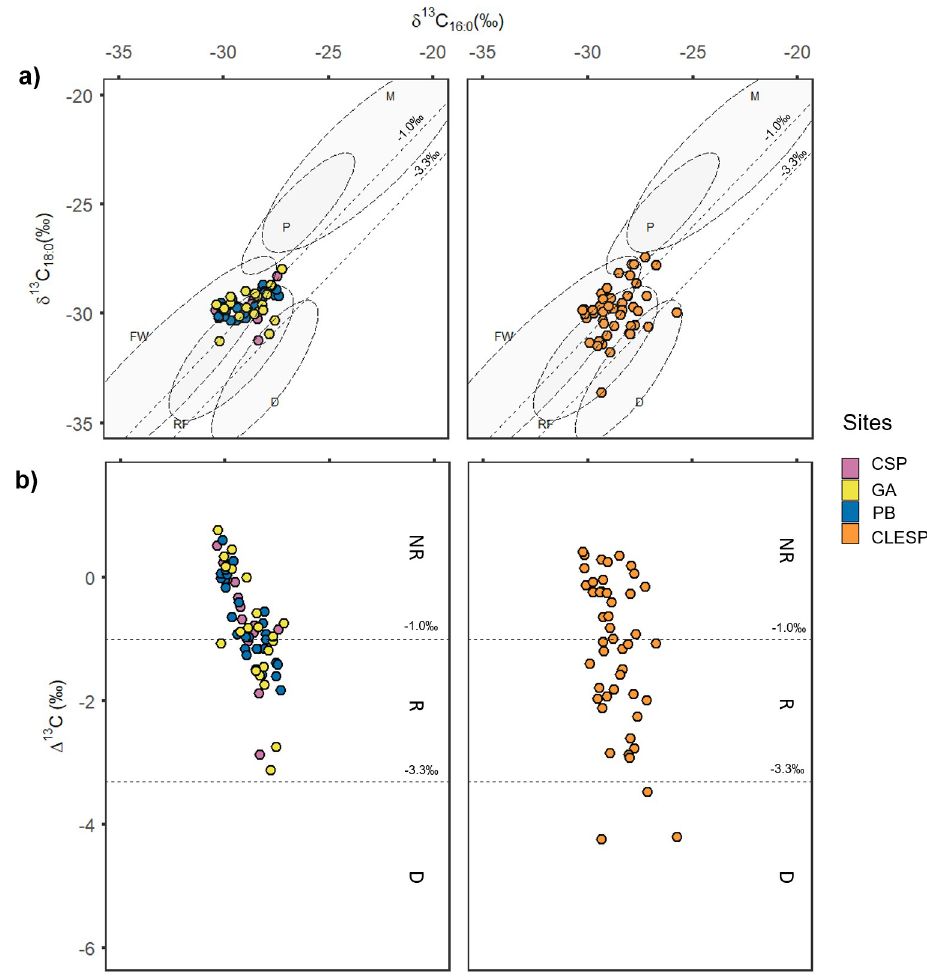
Fig 2. Plots of fatty acid stable isotope values obtained from individual vessels from Sicilian Islamic pottery. a) Plot of δ 13 C 16:0 against δ 13 C 18:0 . Ranges (68% confidence) of 269 modern authentic reference products are shown, D (Ruminant dairy), RF (Ruminant adipose), P (Porcine), M (Marine), and FW (Fresh water). These references are published elsewhere [47] b) Plot of Δ 13 C against δ 13 C 16:0 . values < -3.3‰ are typically associated with D (Ruminant dairy), values between -3.3‰ and -1.0 ‰ are associated with R (Ruminant adipose) and above -1.0‰ can be considered as NR (Non- ruminant)